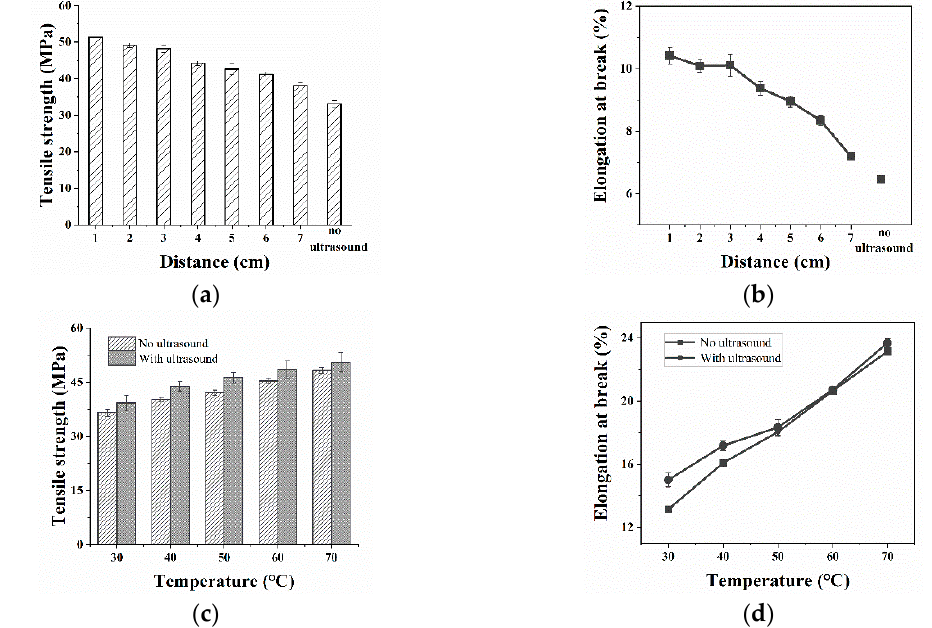
Figure 12. ( a ) The tensile strength of WBG-PP under different temperatures without ultrasound and with ultrasound. ( b ) The elongation at the break of WBG-PP under different temperatures without ultrasound and with ultrasound. ( c ) The tensile strength of WBG-PP at different ultrasound distances. ( d ) The elongation at the break of WBG-PP at different ultrasound distances.